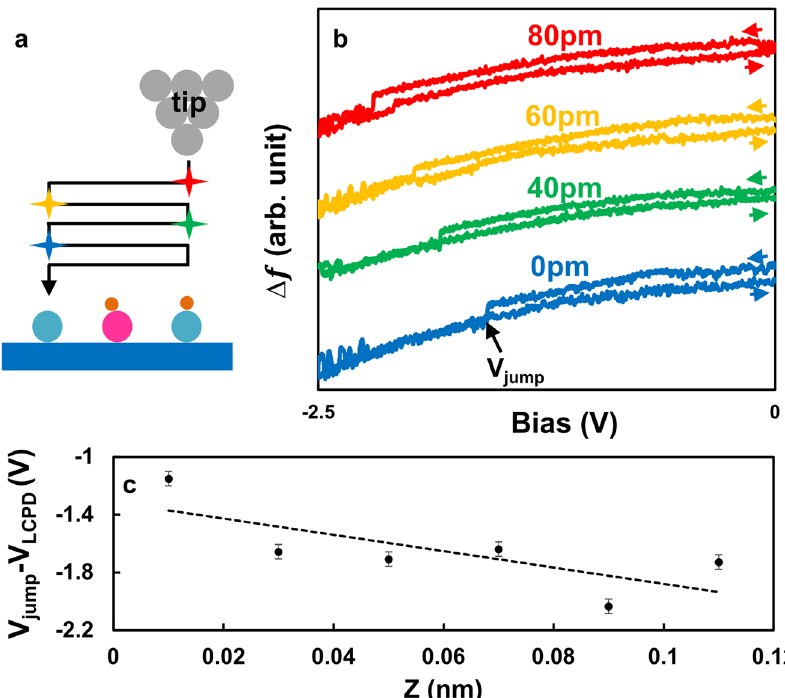
Fig. 2 Distance dependence of KPFS measured on top of O s − (O ad H) − − O s H. a Schematic experimental procedure of distance dependence of KPFS. The black arrow indicates the tip path and the star mark shows the position where KPFS was performed. b KPFS taken at different tip heights, shown relative to the spectrum in blue, that corresponds to the closest tip heights considered. c The vertical axis is the subtraction of bias voltage where the frequency shift jump occurred in KPFS ( V jump ) from the local contact potential difference ( V LCPD ) obtained from the upper parabola in KPFS. The lateral axis is the relative distance from the sample. The black dotted line is a linear fi tting to the data. The slope is − 5.6 V/nm. The error bar indicates the deviation of the bias voltage in V jump